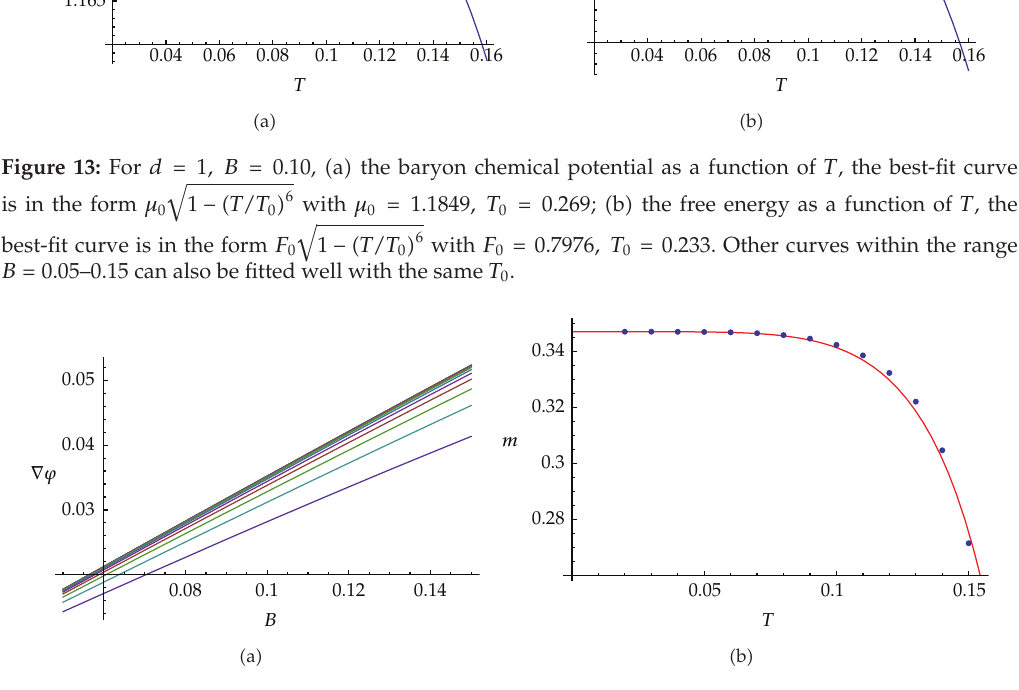
Figure 14: (cid:3) a (cid:4) The pion gradient versus magnetic field for T (cid:8) 0 . 02–0.15 at d (cid:8) 1, lower lines have higher temperatures. (cid:3) b (cid:4) The linear response or slope of the linear function between the pion gradient and the magnetic field as a function of the temperature for the range B (cid:8) 0 . 05–0.15 and density d (cid:8) 1. The red line (cid:14) 1 − (cid:3) T/T 0 (cid:4) 6 with m 0 (cid:8) 0 . 347 , T 0 (cid:8) 0 . is the best-fit curve in the form m 0